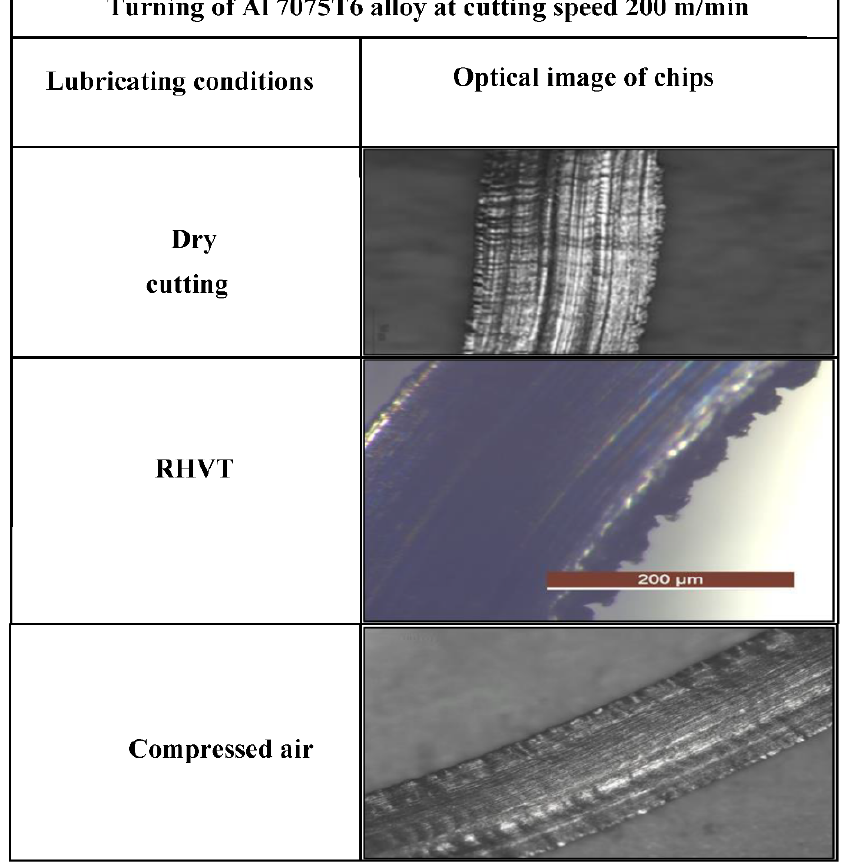
Figure 16. Comparison of chip morphology at different cooling/lubricating machining environ- ments.